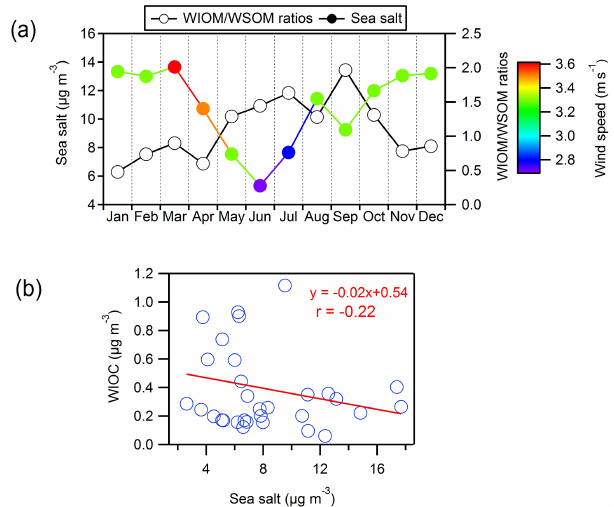
Figure 4. Monthly variations (a) WSIM / WSOM mass ratios and sea salt concentrations and (b) regression analysis between water- insoluble organic carbon (WIOC) and sea salt concentrations. The color scale in (a) indicates the wind speed over the western North